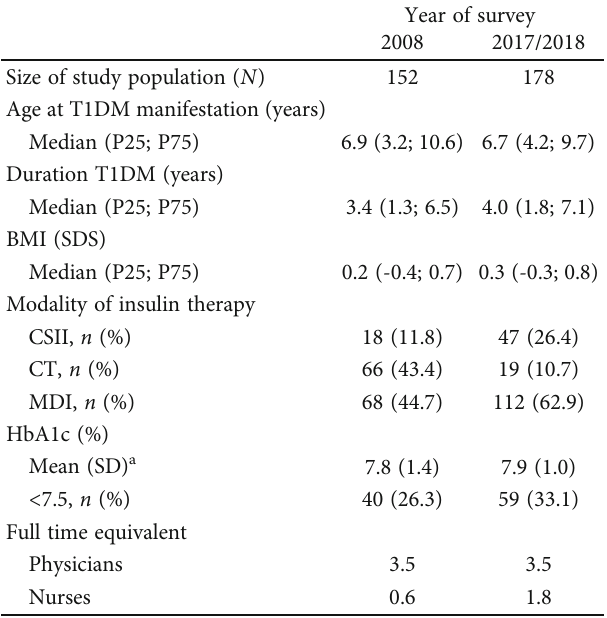
Table 3: Comparison of study characteristics between patients surveyed in 2008 and